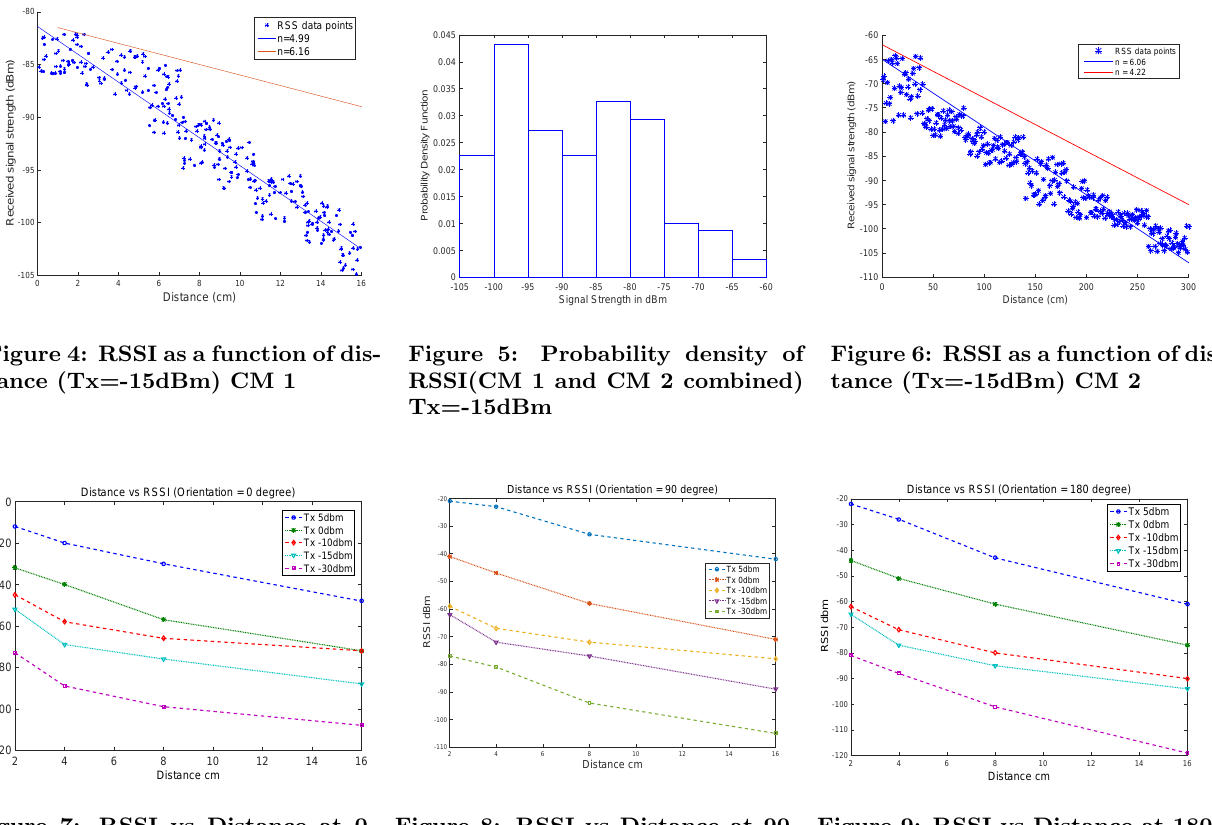
Figure 7: RSSI vs Distance at 0 degree antenna orientation